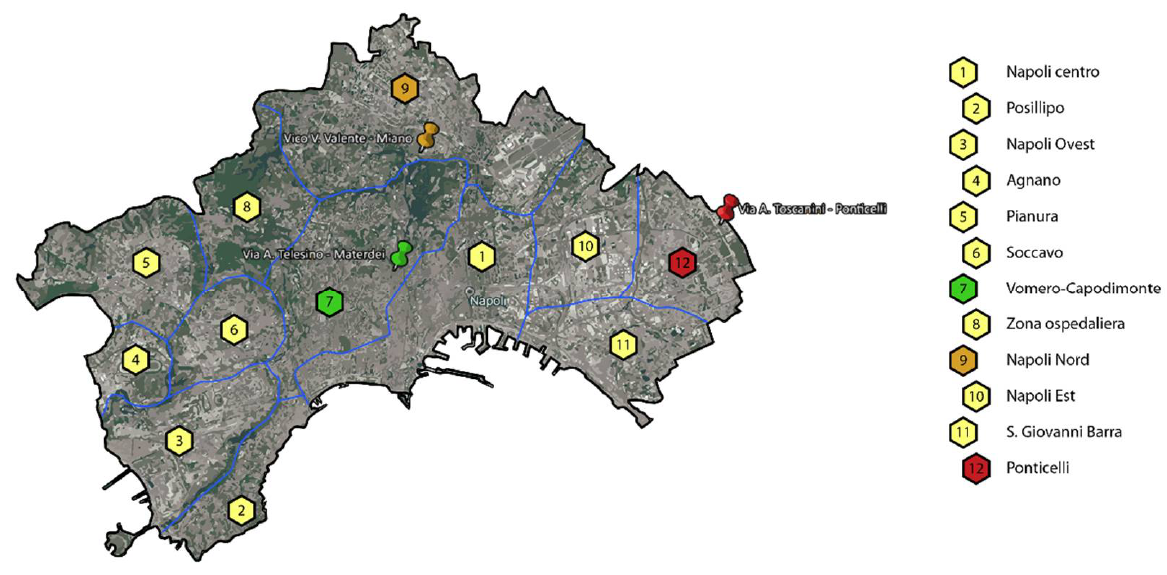
Figure 2. Territorial framing of the experimentation areas in the city of Naples.